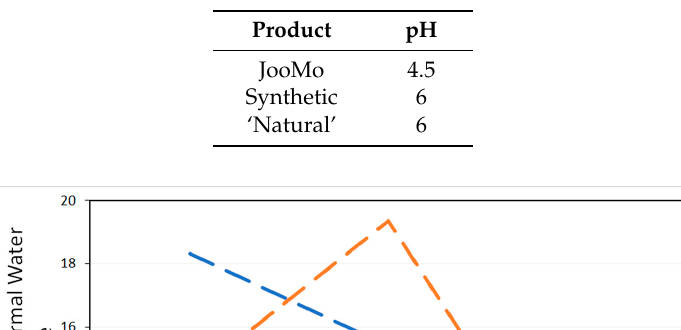
Figure 13. Tewameter (TEWL) averages at all time points. Table 5. Average percentage change in TEWL for all product groups.